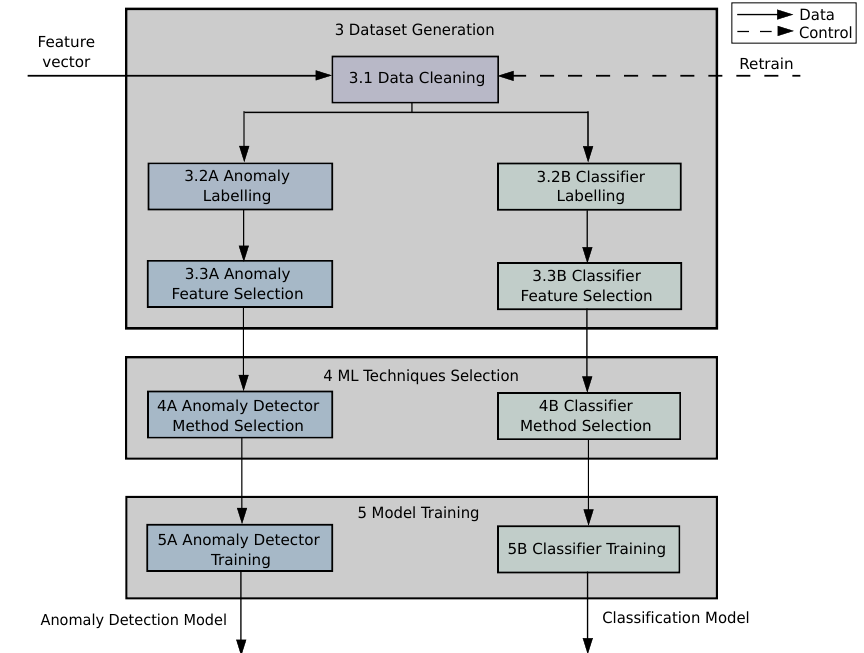
Figure 4. Design of the Offline Model Generation module to detect and classify ransomware in